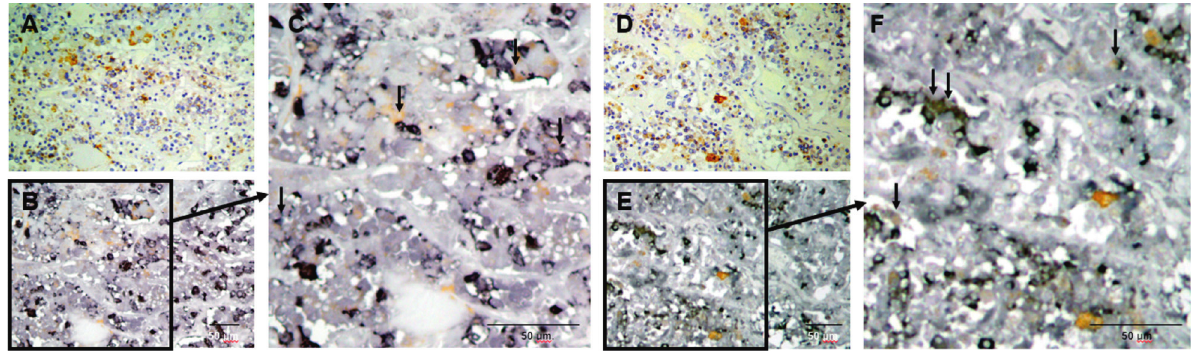
Figure 5: Double staining of (pro)renin receptor staining and thyroid-stimulating hormone or prolactin. (A), (D) (Pro)renin receptor staining counterstained with hematoxylin; (B) double staining of (pro)renin receptor and thyroid-stimulating hormone in the identical section as (A); (C) high-power field of (B); (E) double staining of (pro)renin receptor and prolactin in the identical section as (D); and (F) high-power field of (E). Arrows indicate cells costained with (pro)renin